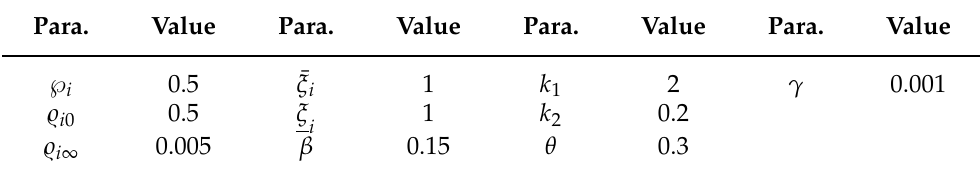
Table 1. Parameters of the proposed scheme with i = 1,2,3.